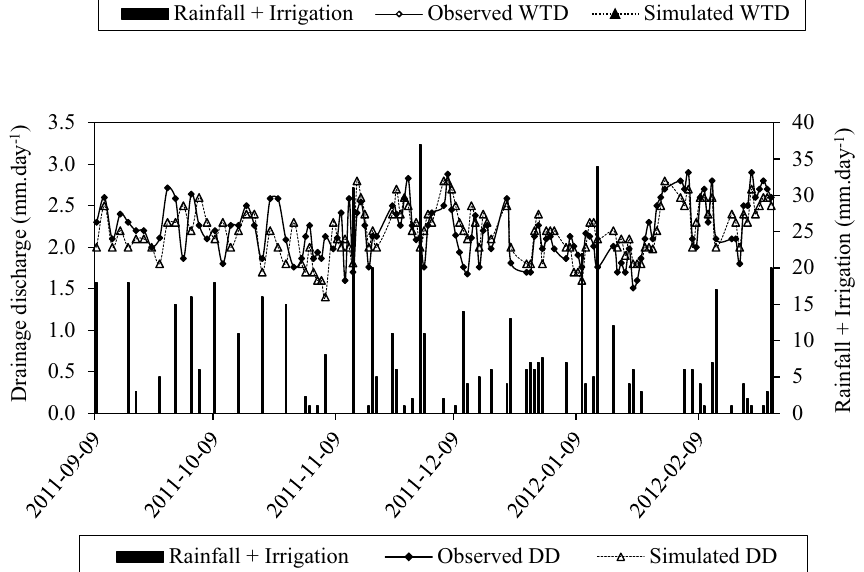
Fig. 7 Drainage discharge fluc- tuation during validation